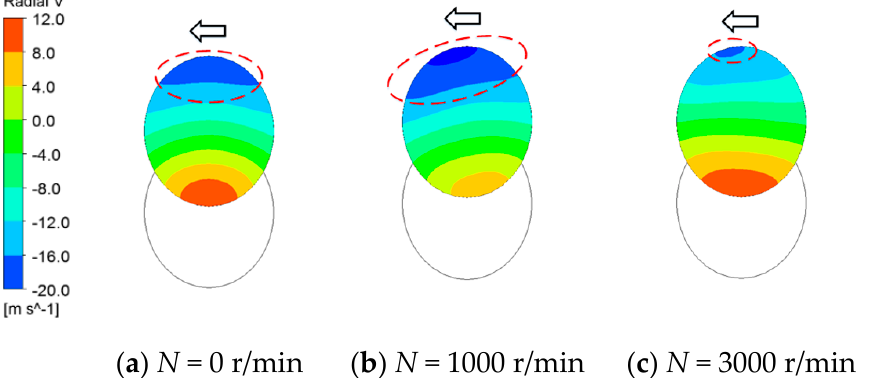
⁄ under different radial inclination angles (0°, 15°, with 𝑈 𝑊 d ax with under different radial inclination angles (0°, 15°, 𝐶𝐶 d 𝑈𝑈 𝑊𝑊 ax ⁄